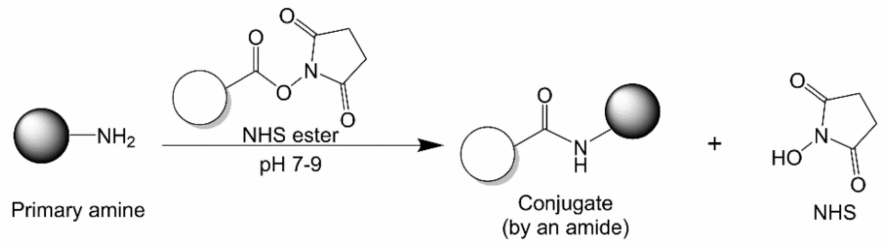
Figure 6. N-hydroxysuccinimide